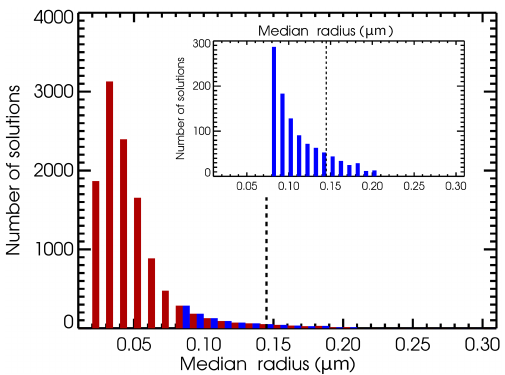
Figure 9. Like Fig. 7 but for Case 2. The inset box shows the blue histograms (reduced solution set) with an expanded y axis scale for better